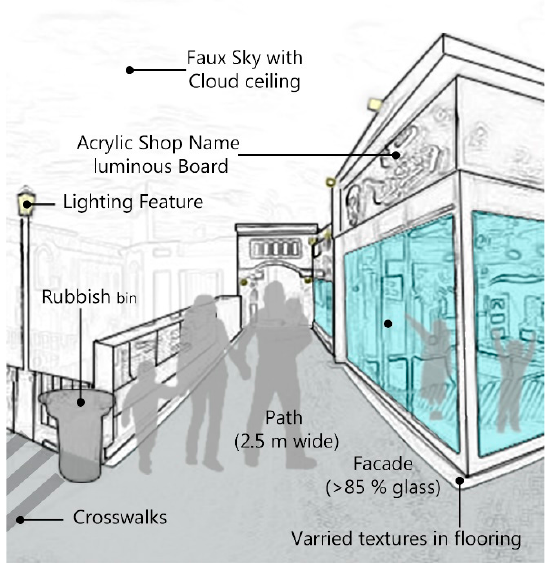
Figure 5. Clearance of sight, increasing interaction between guardians and children. Source(s): Authors (2022).